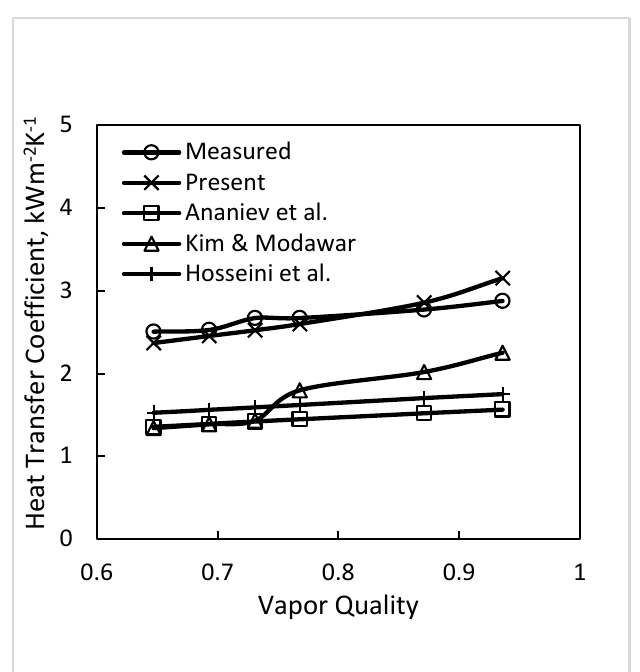
Figure 5. Data of Kondou and Hrnjak [13] for carbon dioxide compared to some correlations. T SAT = 14.3 °C, G = 100 kg·m − 2 s − 1 .